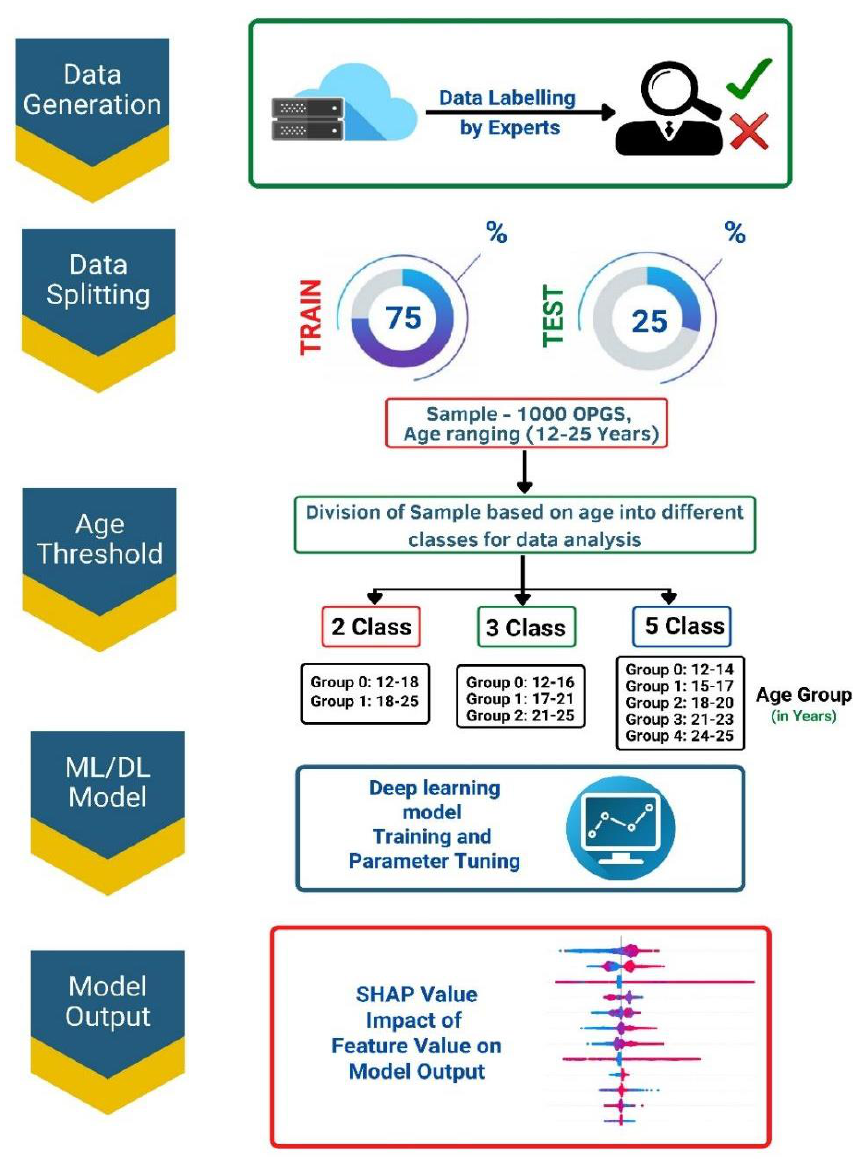
Figure 2. Block diagram illustrating the various steps involved in building a Deep Learning–based tool for automated analysis and classification of data into the specified